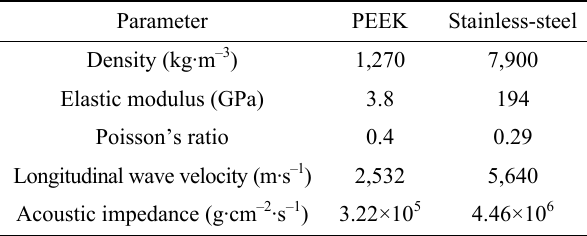
Table 1 Physical parameters of PEEK and stainless-steel.